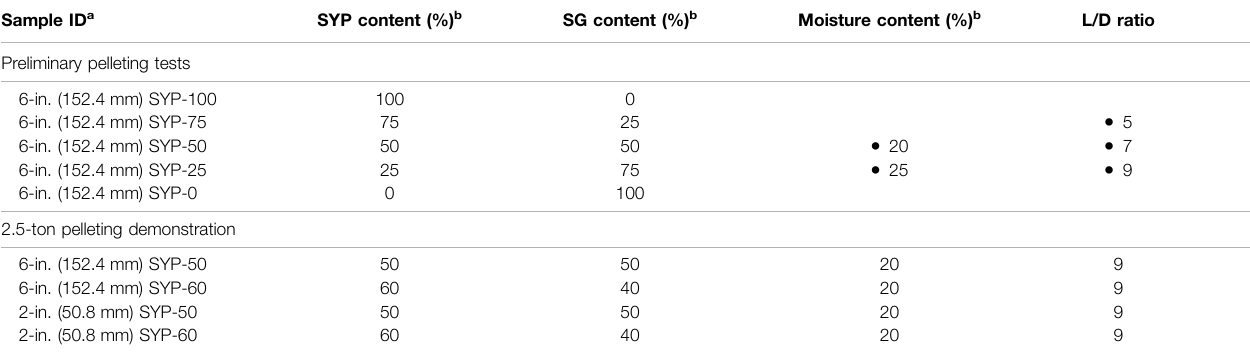
TABLE 1 | Experimental plan for preliminary and 2.5-ton high-moisture pelleting tests of southern yellow pine (SYP), switchgrass (SG), and their blends. Sample ID